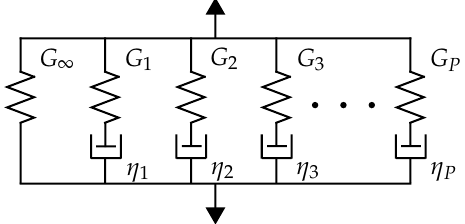
Figure 1. Scheme of the generalized Maxwell